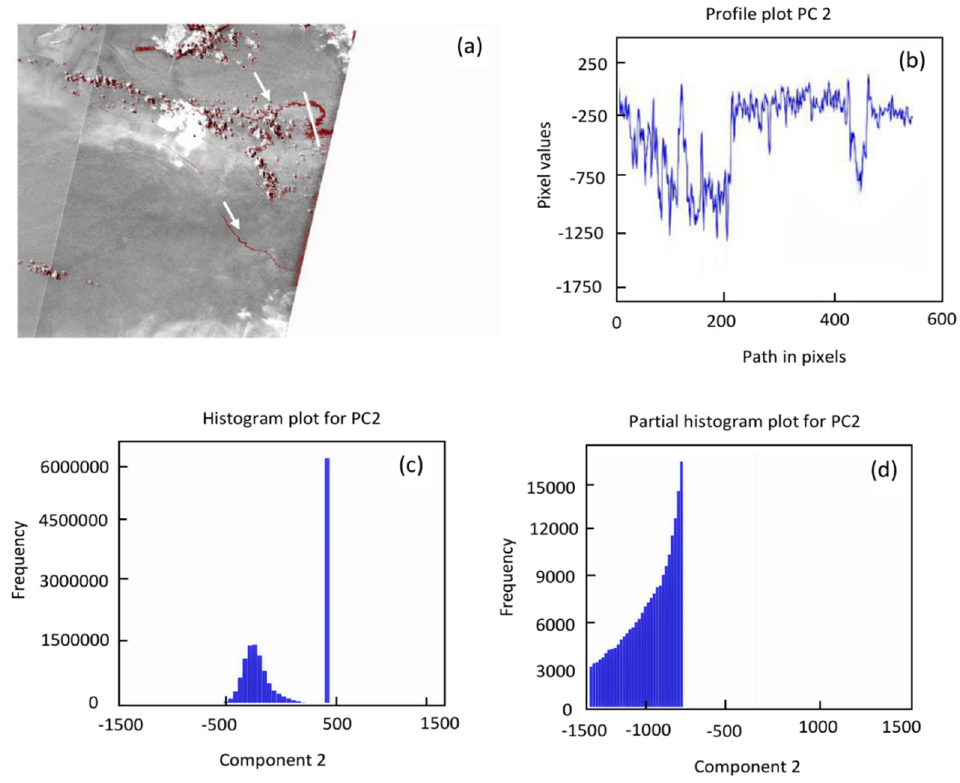
Figure 5. ( a ) The PCA component 2 was estimated from Sentinel-2 bands on 2 September 2021, ( b ) Cross-section profile plot of component 2, ( c ) Component 2 histogram, ( d ) Component 2 partial histogram for predefined values.